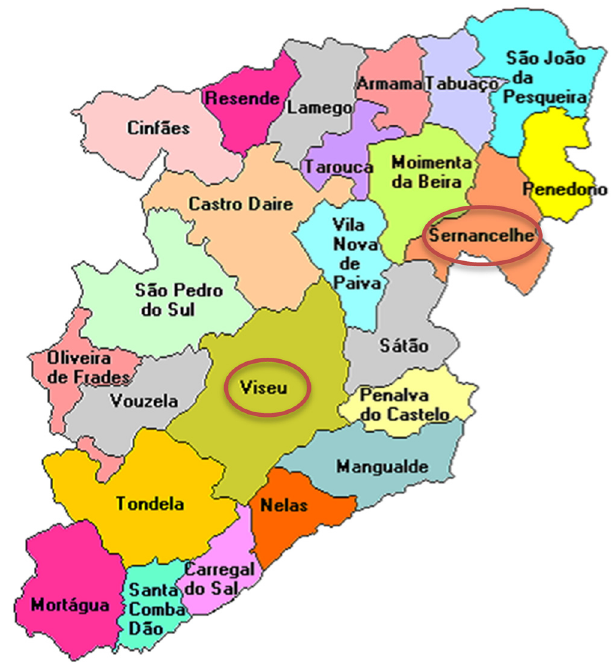
Figure 1: Geographic origins of the samples used in the study.